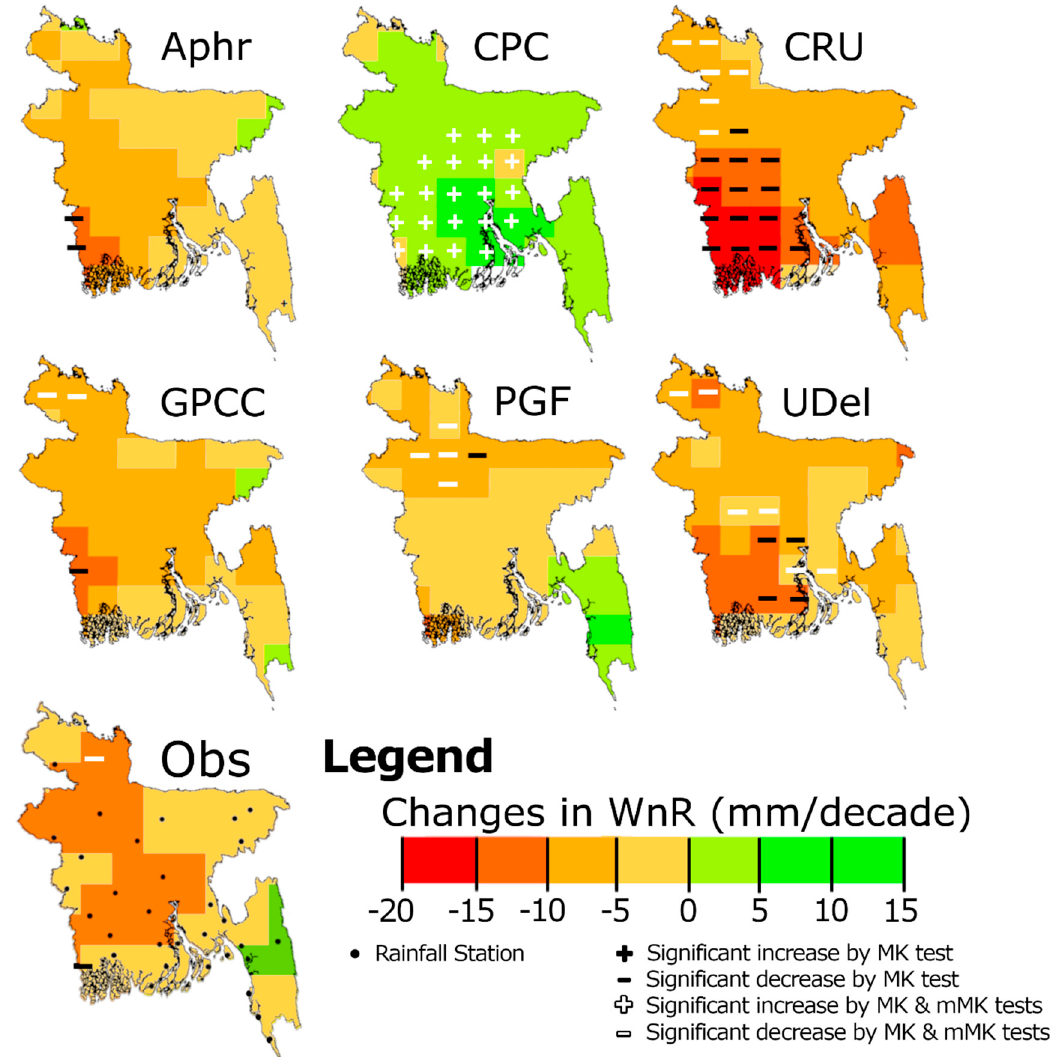
Figure 12. Trends in winter rainfall (WnR) in Bangladesh during 1979–2010.